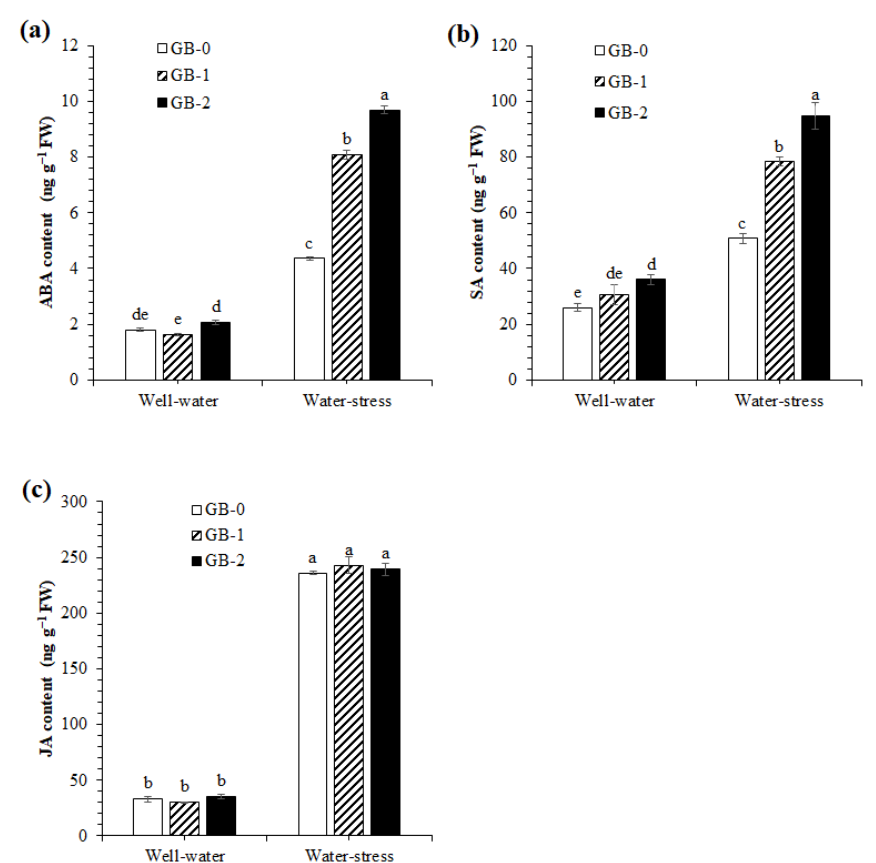
Figure 5. Effect of GB root-priming on hormones accumulation (ABA, SA, and JA) in the roots of wheat seedling grown under well-water and water-stress conditions ( a – c ). Each value represents the mean ± standard deviation (SD) of three replicates. Bars showing different letters represent the significant differences at p ≤ 0.05 as determined by LSD test.